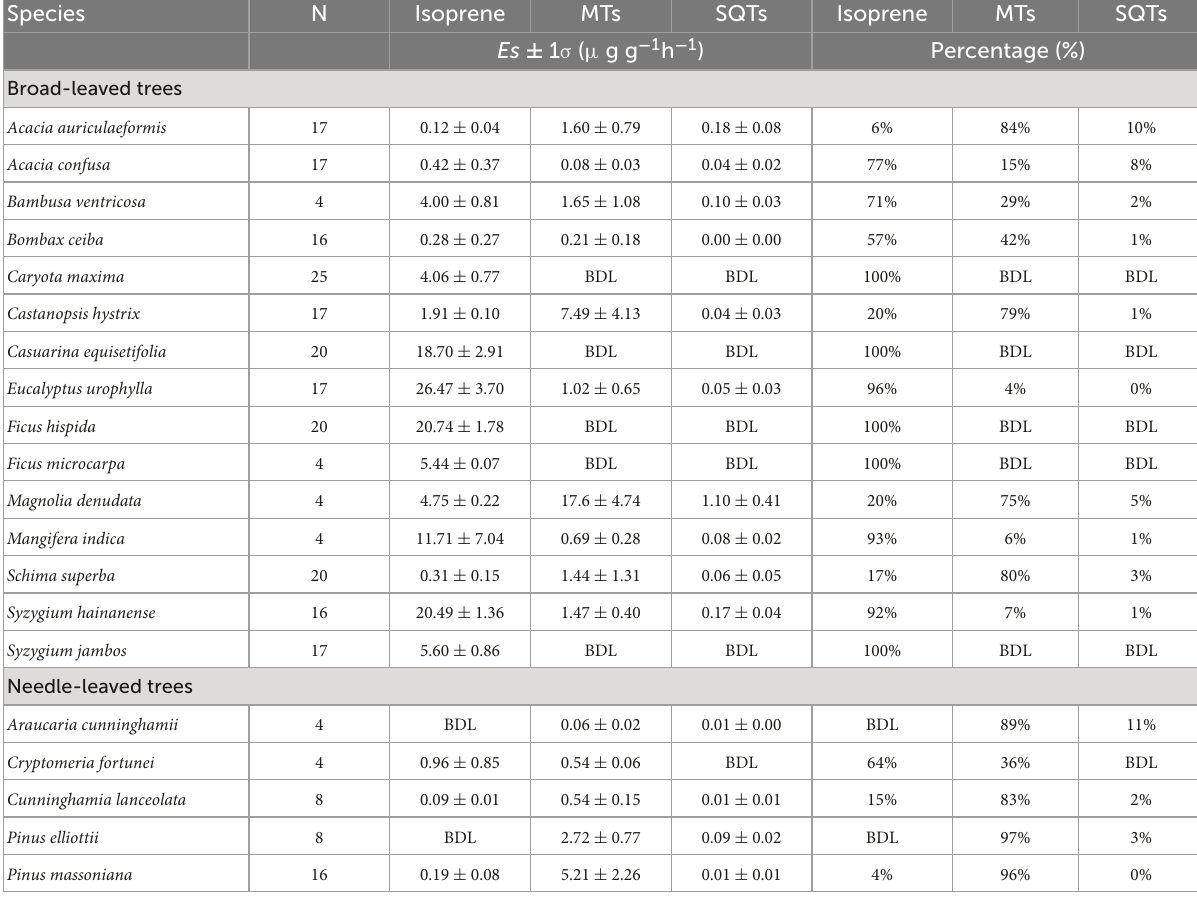
TABLE 1 Emission factors and percentages of isoprene, monoterpenes (MTs) and sesquiterpenes (SQTs) for the 20 measured